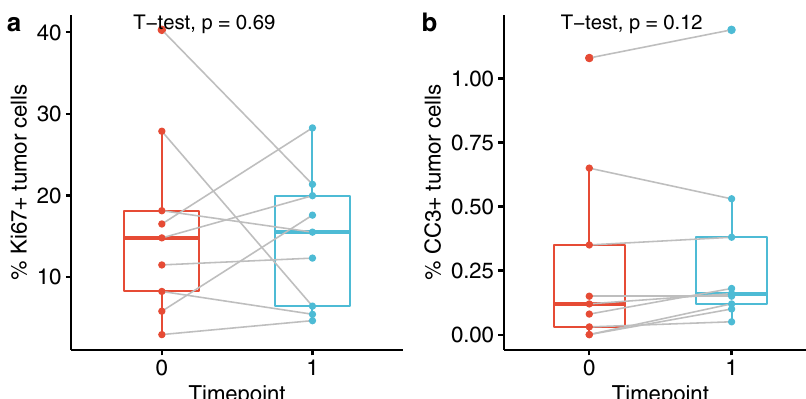
Fig. 7 Intralesional anti-PD-1 did not decrease tumor cell proliferation or increase tumor cell apoptosis. Proliferating Ki67 + tumor cell densities ( a ) and cleaved caspase 3 (CC3) positive tumor cell densities ( b ) at timepoint 0 (pre-therapy) and timepoint 1 (post-therapy) are shown. The bounds of each box represent the interquartile range (IQR). The horizontal line within a box is the median. Whiskers extend to the largest and smallest values no further than 1.5*IQR. Outlying points beyond the ends of the whiskers are plotted individually. Each pair of connected points represents one patient ’ s data; p -values are derived from paired t